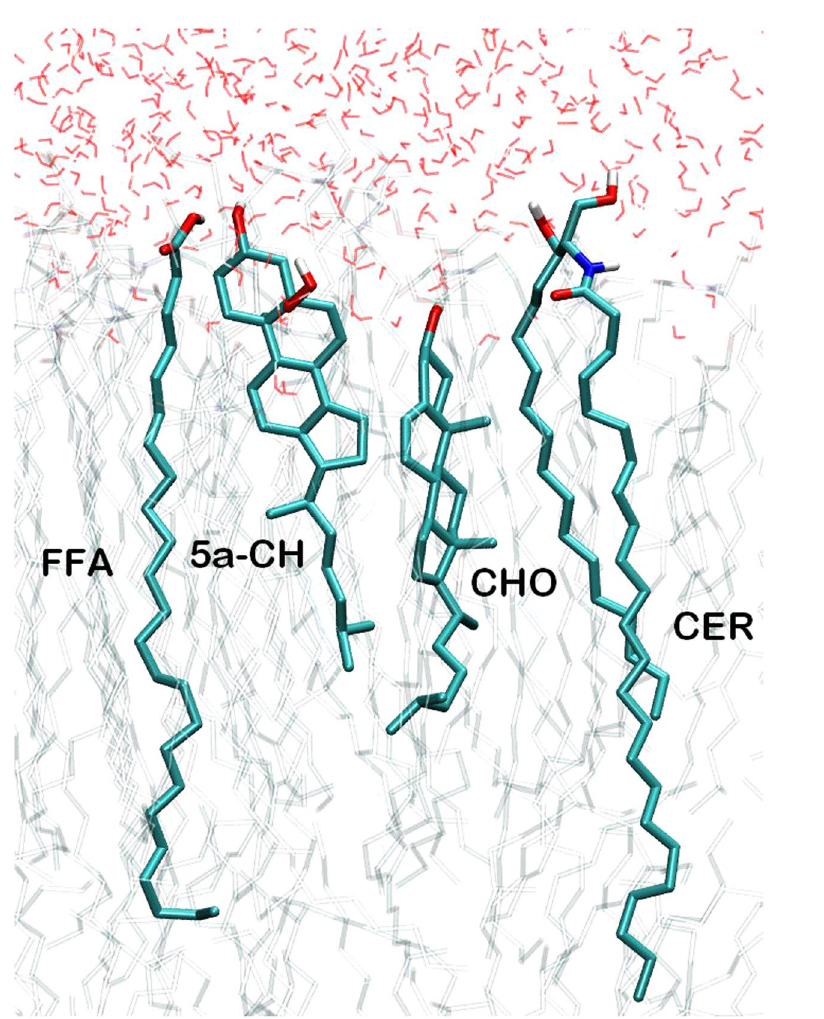
Figure 4. Selected lipids in “CER + CHO + FFA + 5 α -CH” systems. Atoms are represented according to the following: White H, cyan C, blue N, and red